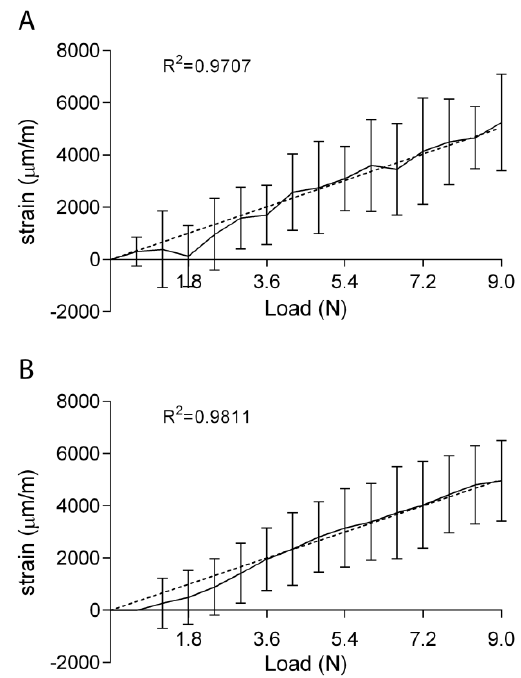
Figure 3. Experimental values and linear interpolation of a representative test performed loading the specimen with a step signal, and measuring the strain with the micro strain gauge ( A ) and DIC ( C ). The global shortening was measured with the length transducer for the strain gauge ( B ) and DIC ( D ) tests.